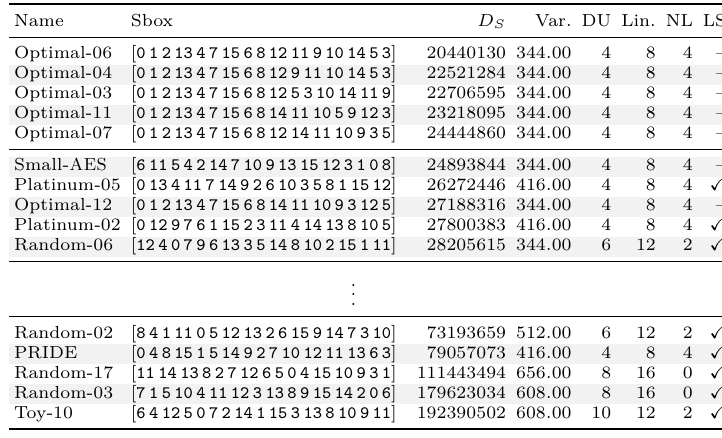
Table 11: S-box properties, in ascending order by D S . DU = differential uniformity, lin. = linearity, NL = nonlinearity, LS = linear